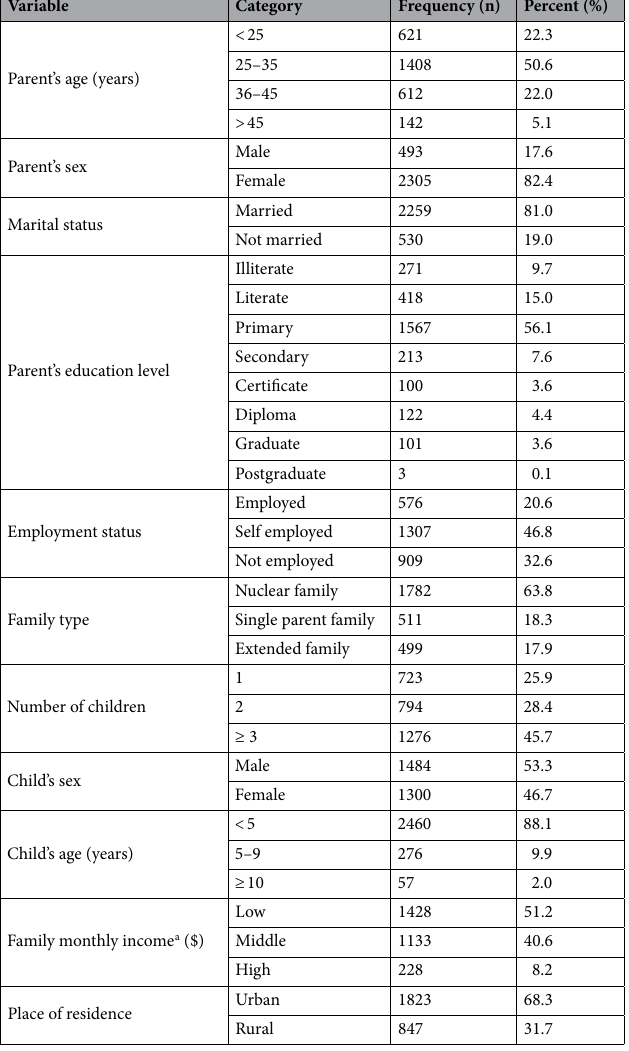
Table 1. Parents’ and children’s sociodemographic information. a The classification of family income used a world bank definition of poverty of population living on less than $1.25 per day.